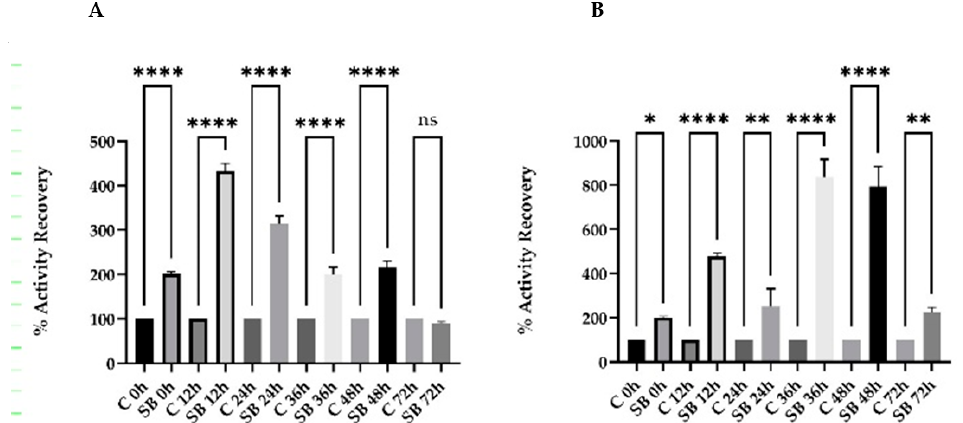
Figure 8. Percentage of recovery of hSCOMT activity in the presence and absence of Stabilizer Buffer ( A ) 4 °C; ( B ) − 80 °C for a period of 0, 12, 24, 36, 48, and 72 h. Each value represents the average of 3 independent samples. The Control Buffer ( C ) and Stabilizer Buffer (SB) were composed, respectively, by 50 mM of Tris-Cl pH 7.8, 50 mM NaCl, 1 mM MgCl 2 , 5 mM imidazole, and 50 mM of Tris-Cl pH 7.8, 150 mM NaCl, 1 mM MgCl 2 , 15 mM cysteine, 5 mM trehalose, 5% glycerol, and 10 mM [C 4 min]Cl. ( p -value * < 0.05; ** < 0.01; **** < 0.0001).